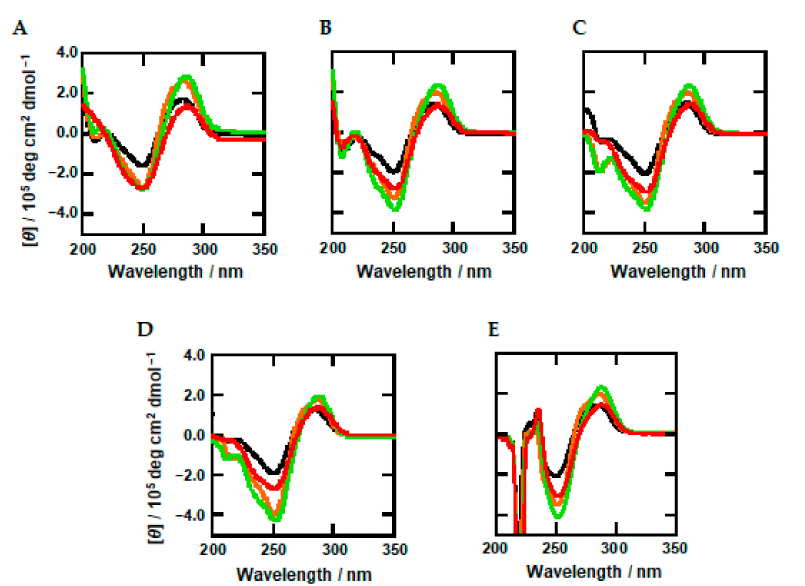
Figure 2. CD spectra of 20 µ M oligonucleotides. CD spectra in a buffer containing 100 mM KCl, 10 mM K 2 HPO 4 (pH 7.0), and 1 mM K 2 EDTA in the absence of cosolutes ( A ) or in the presence of 30 wt% cosolutes (PEG200 ( B ), TMAO ( C ), urea ( D ), and L-proline ( E )) at 25 ◦ C. Me0: black, Me3: orange, Me5: green, and Me8: